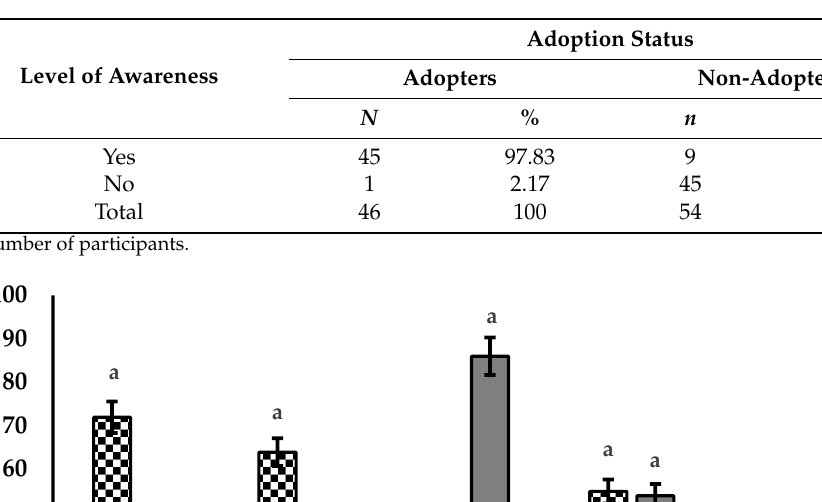
Table 7. Awareness status of CSIT in the study areas.